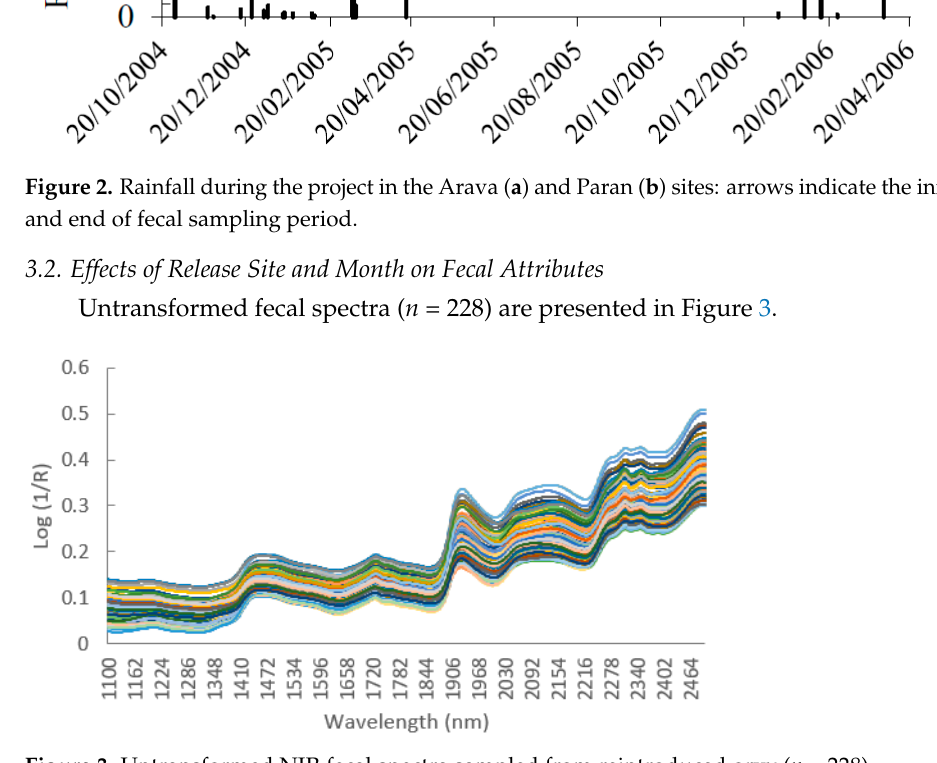
Figure 3. Untransformed NIR fecal spectra sampled from reintroduced oryx ( n = 228). The average and median NIR spectral distances (Mahalanobis H values) from the centroid of the Arava spectral population to Paran spectral centroid were 2.6 and